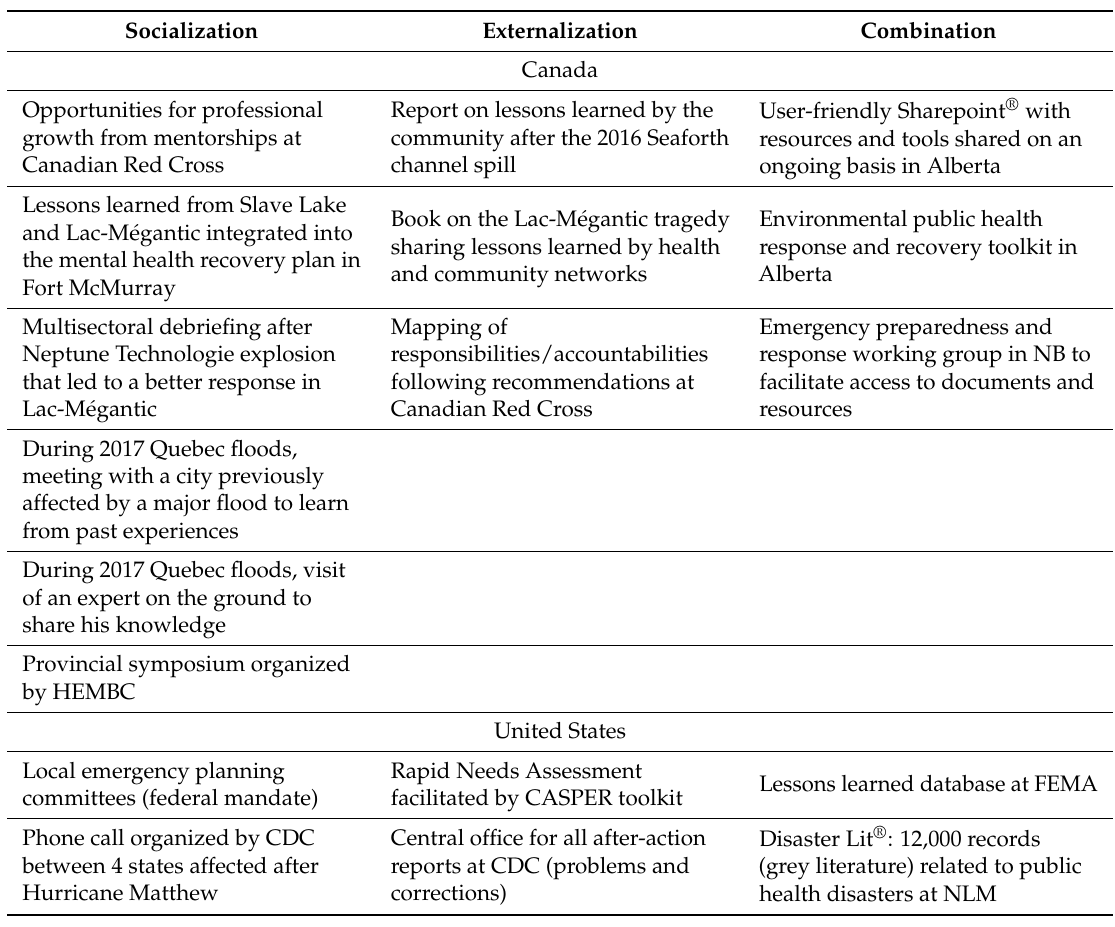
Table 2. Examples of promising KTA